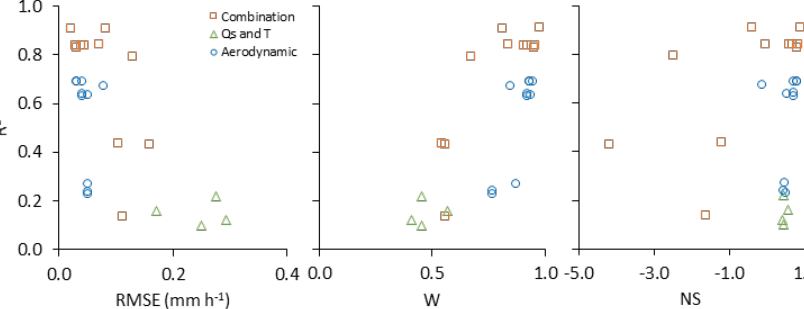
Figure 14. Map of the indicators of the model adjustment ( R 2 = coefficient of determination, RMSE = root mean square error, W = index of agreement, NS = Nash and Sutcliffe index.